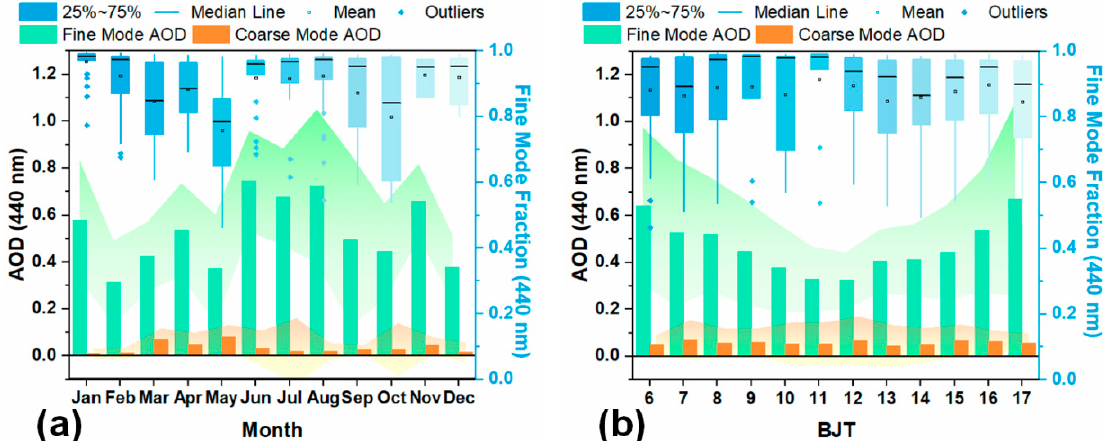
Figure 2. Monthly ( a ) and diurnal ( b ) variation in columnar fine/coarse AOD, fine-mode fraction (FMF, 440 nm), throughout the whole study period. The translucent bands in green and orange represent the standard deviation ranges for the fine and coarse modes, respectively. The boxplots in blue denote monthly/hourly variation in FMF at 440 nm. “BJT” denotes Beijing standard time (UTC + 08).